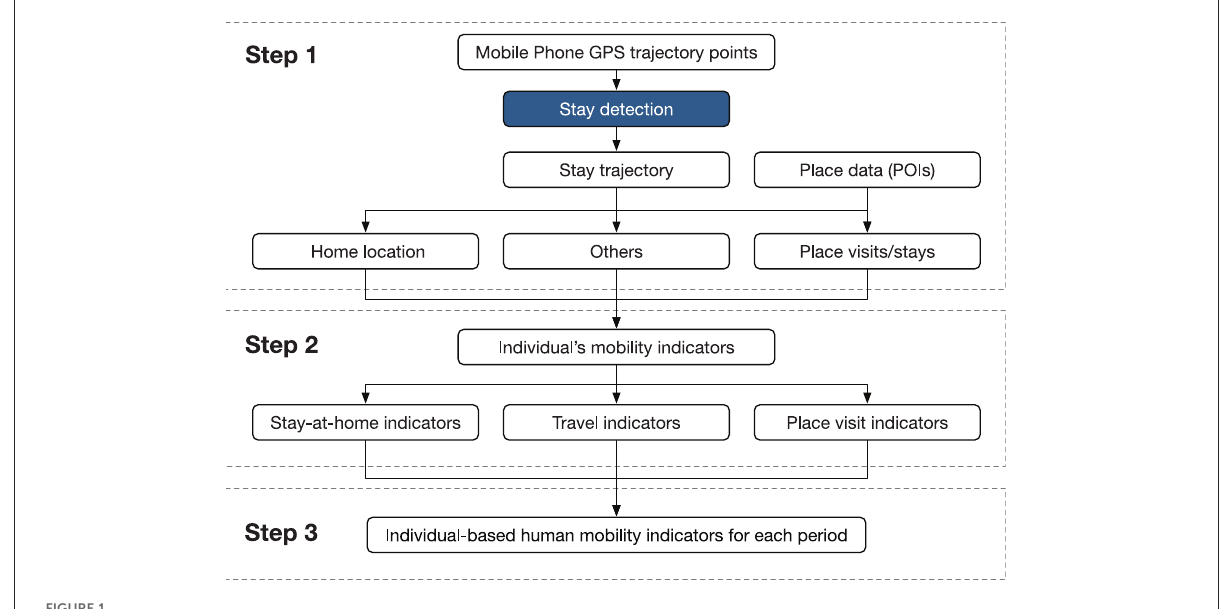
FIGURE1 Analysis framework of detecting a user’s daily mobility indicators from GPS trajectory data.